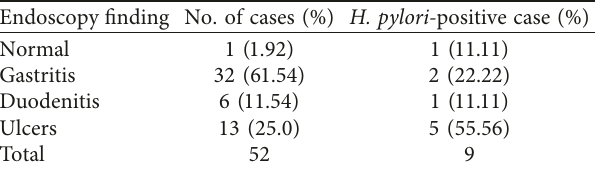
Table 2: Comparison of endoscopy findings and positive H. pylori tests ( n � 52).